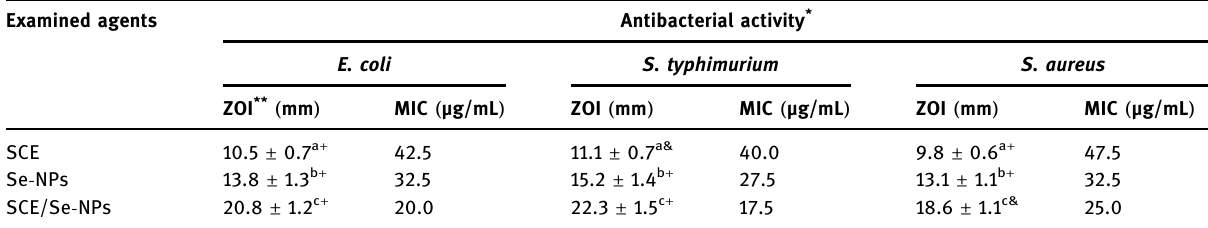
Table 1: Antimicrobial powers of phytosynthesized Se - NPs with SCE Examined agents Antibacterial activity *